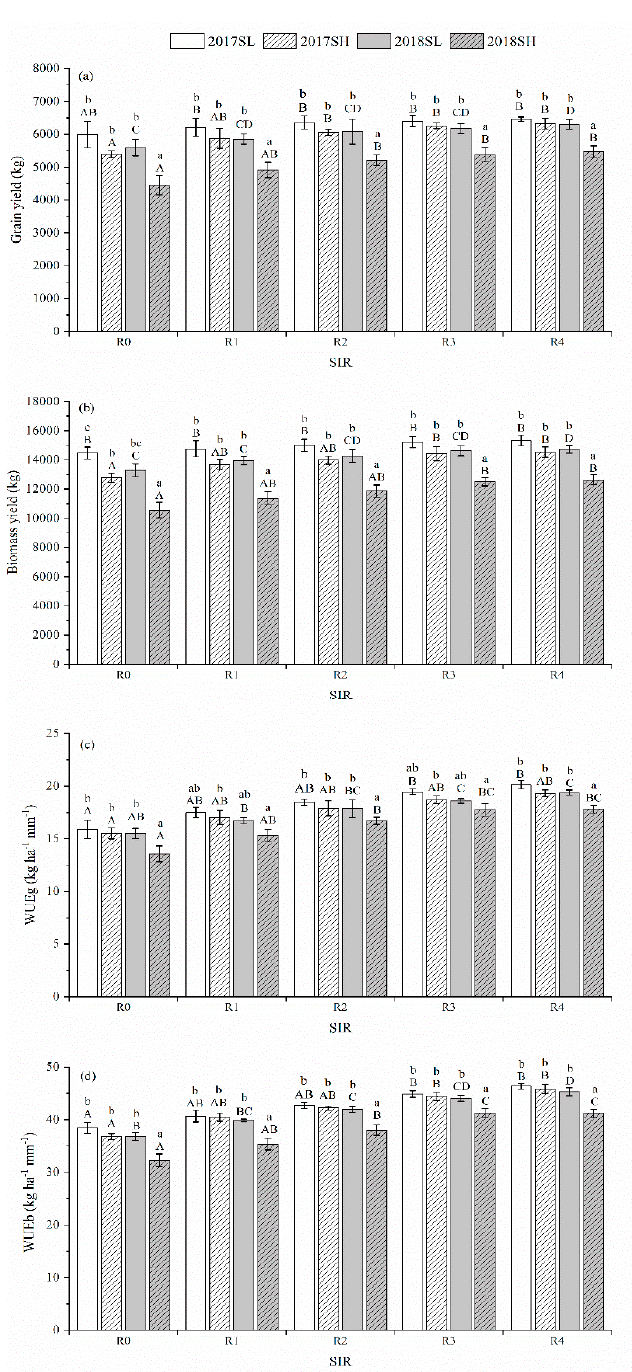
Figure 5. Grain yield ( a ), biomass yield ( b ), and water use e ffi ciency at grain ( c ) and biomass ( d ) level response to straw incorporation rates (SIR) and irrigation water salinity (IWS) in 2017 and 2018. Note: SL indicates the low salinity water (1.92 dS m − 1 ); SH indicates the high salinity water (3.20 dS m − 1 ). Lowercase letters indicated significant di ff erences between di ff erent YEAR and IWS combinations for the same SIR treatment and uppercase letters indicate significant di ff erences between di ff erent IWS and SIR combinations for the same YEAR. Data without a same letter di ff er significantly at the p = 0.05